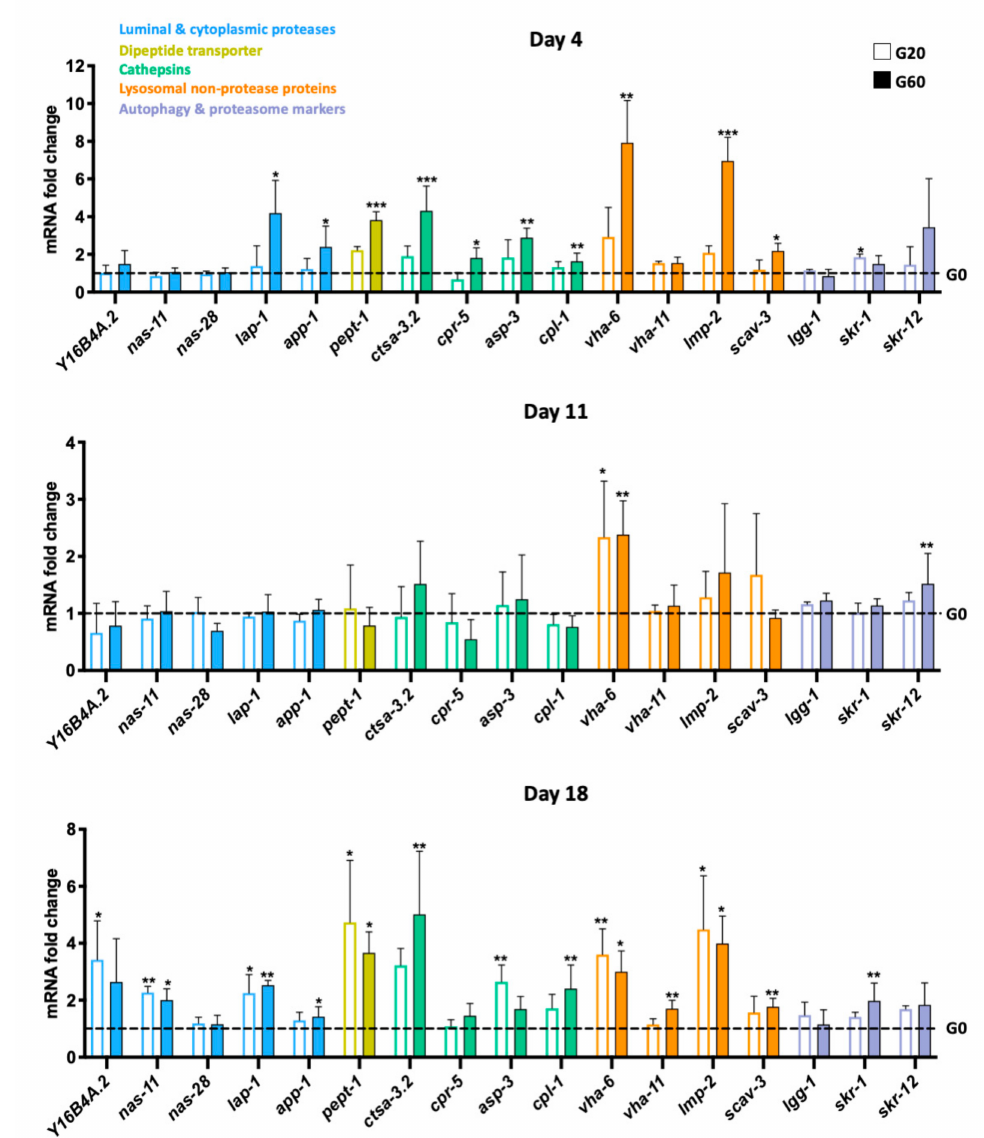
Figure 3. Impact of dietary N ε -carboxymethyllysine (dCML) exposure on transcriptional regulation of some digestive enzymes, lysosomal proteins and proteasomal and autophagy markers. Young adult worms were fed with bacteria, which were pretreated with 0 mM (G0), 20 mM (G20) or 60 mM (G60) of glyoxylic acid. After 4, 11 and 18 days of culture, relative expression of genes coding for luminal and/or cytoplasmic proteases, cathepsins, lysosomal nonprotease proteins, an autophagy marker and proteasome markers were analyzed by comparing all the conditions to the G0. Data were expressed as means ± standard deviation of 3 biological replicates. The cdc-42 and pmp-3 genes were used to normalize levels of gene expression. * p ≤ 0.05, ** p ≤ 0.01, *** p ≤ 0.001 G20 or G60 vs. G0 (Kruskal–Wallis, Dunn’s multiple comparisons